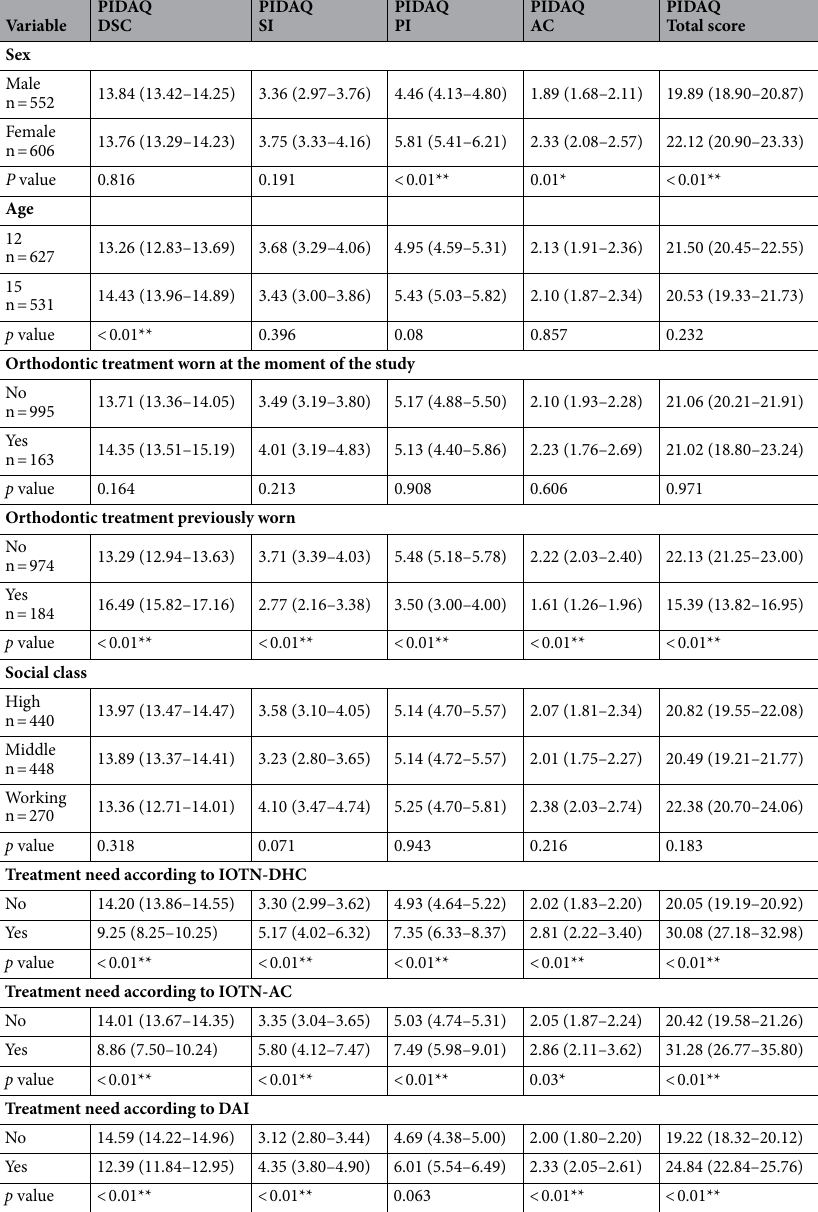
**Highly significant p value <